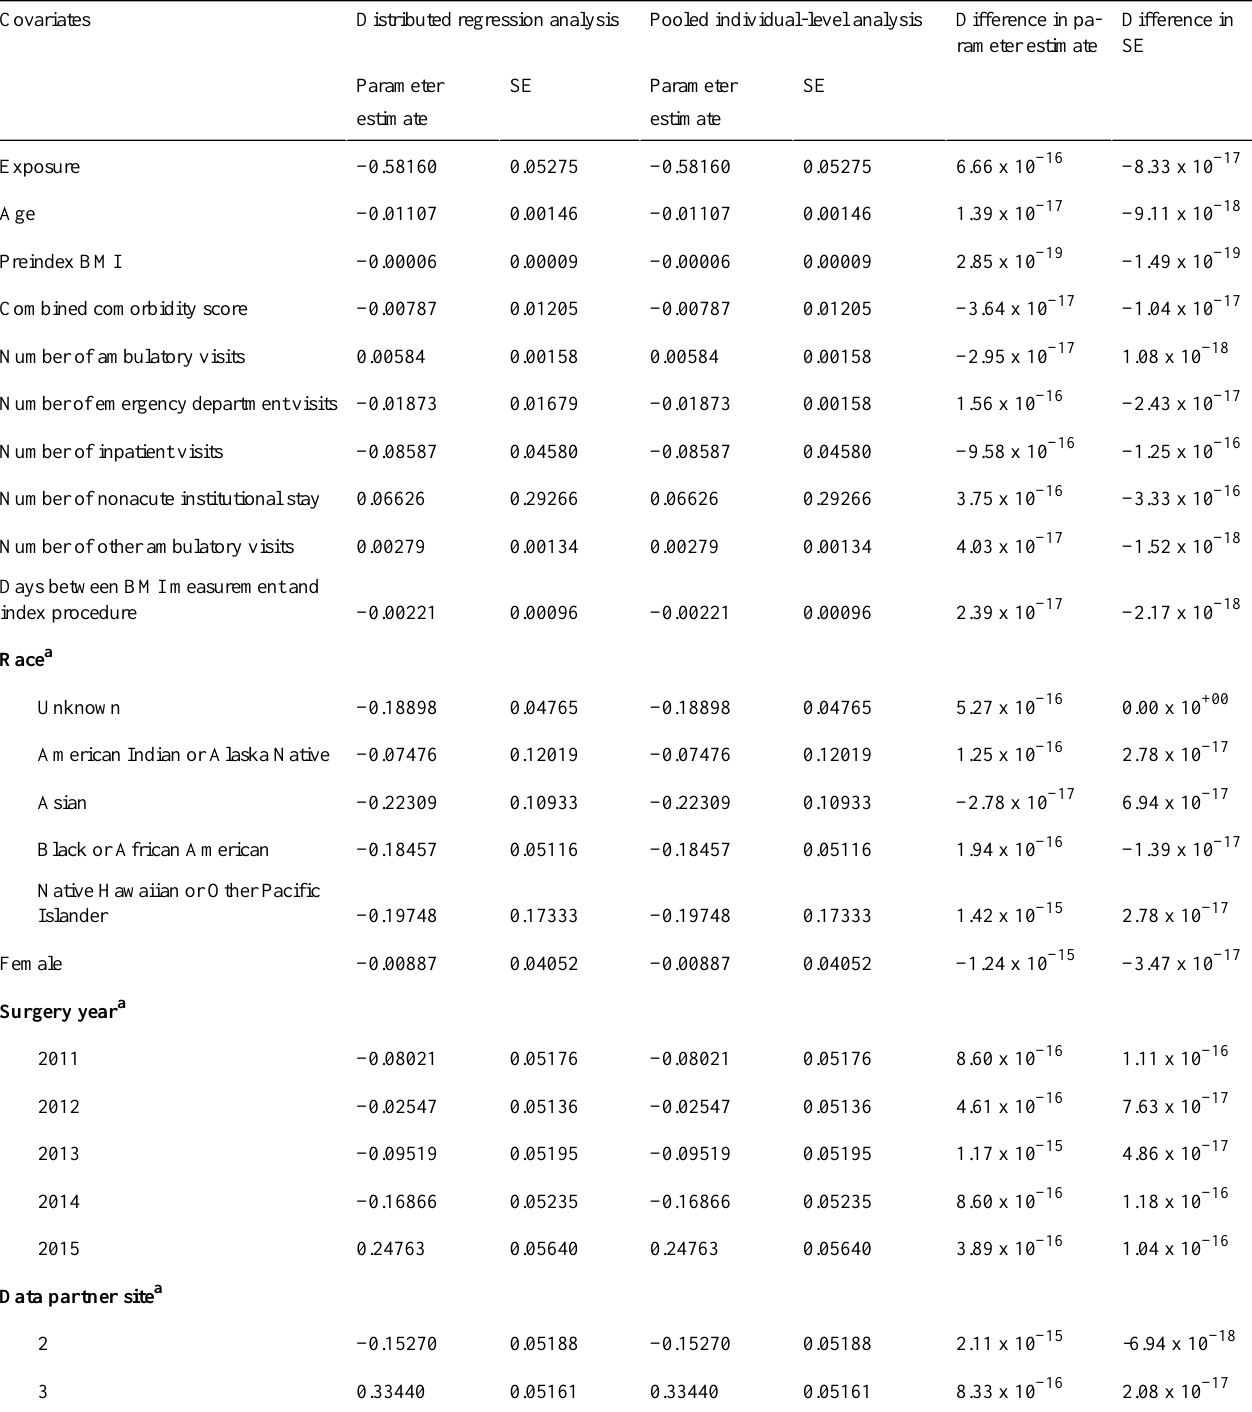
Table 4. Distributed Cox proportional hazards regression vs pooled individual-level Cox proportional hazards